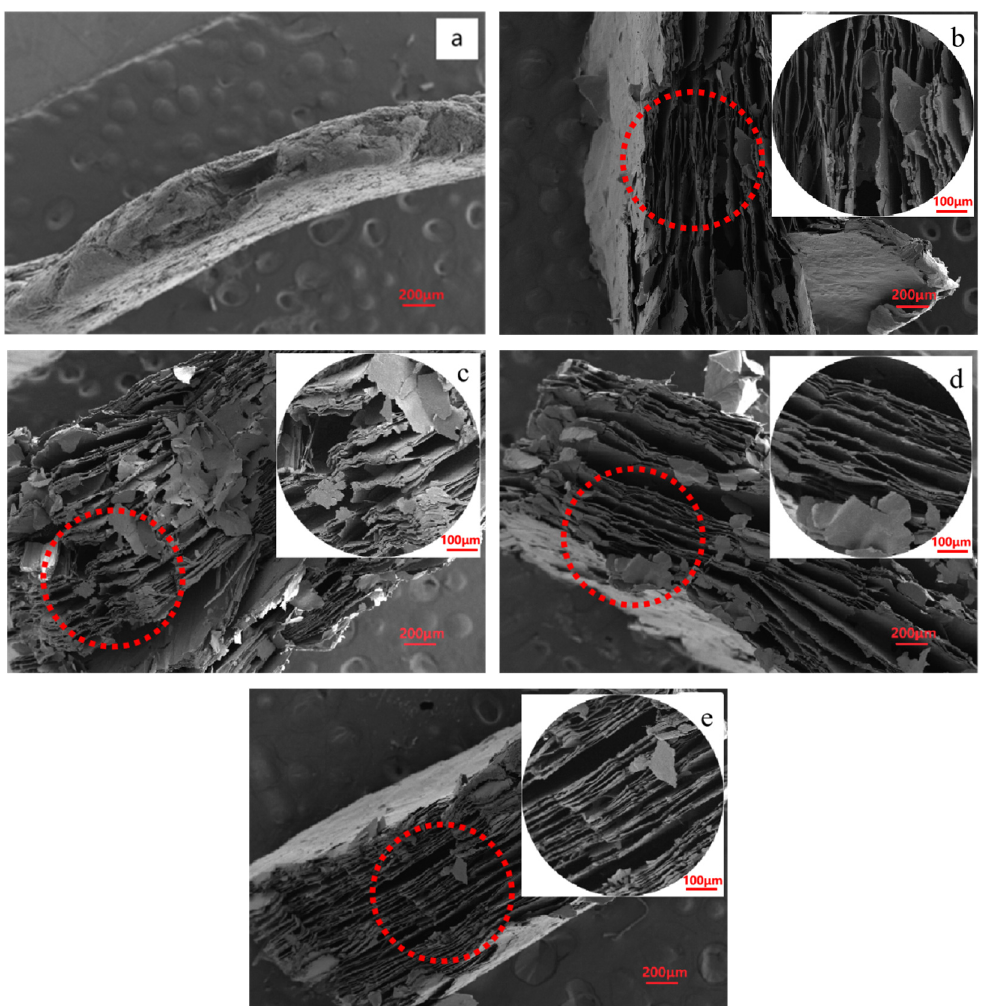
Figure 5. SEM images at different additions of manganese dioxide: ( a ) Vrm, ( b ) 0.001 g, ( c ) 0.005 g, ( d ) 0.01 g, and ( e ) 0.02 g.